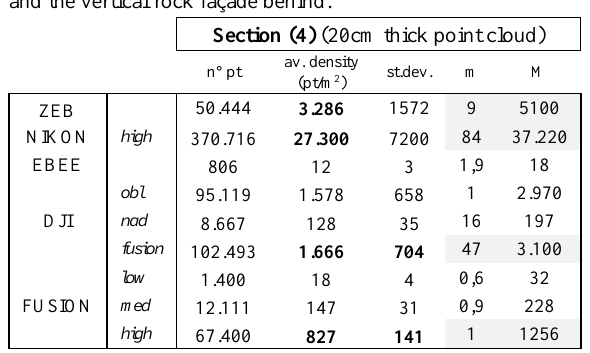
Figure 18. Section (4) on terrestrial photogrammetric model